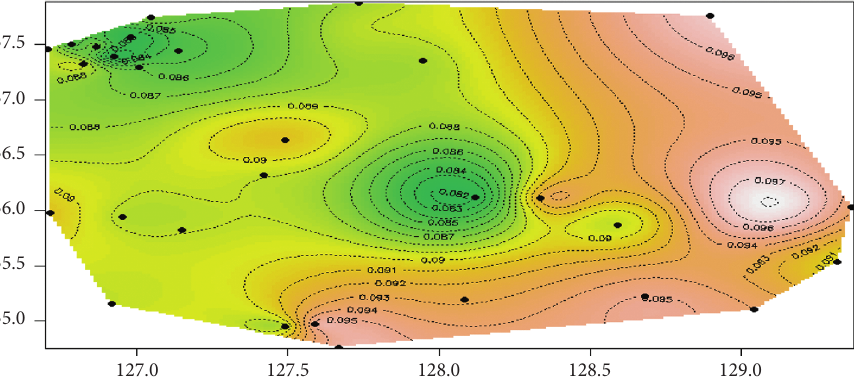
Figure 7: Interpolation of the 10 years’ return level for ozone concentration in 29 air monitoring sites versus longitude ( x -axis) and latitude ( y -axis) in South Korea.